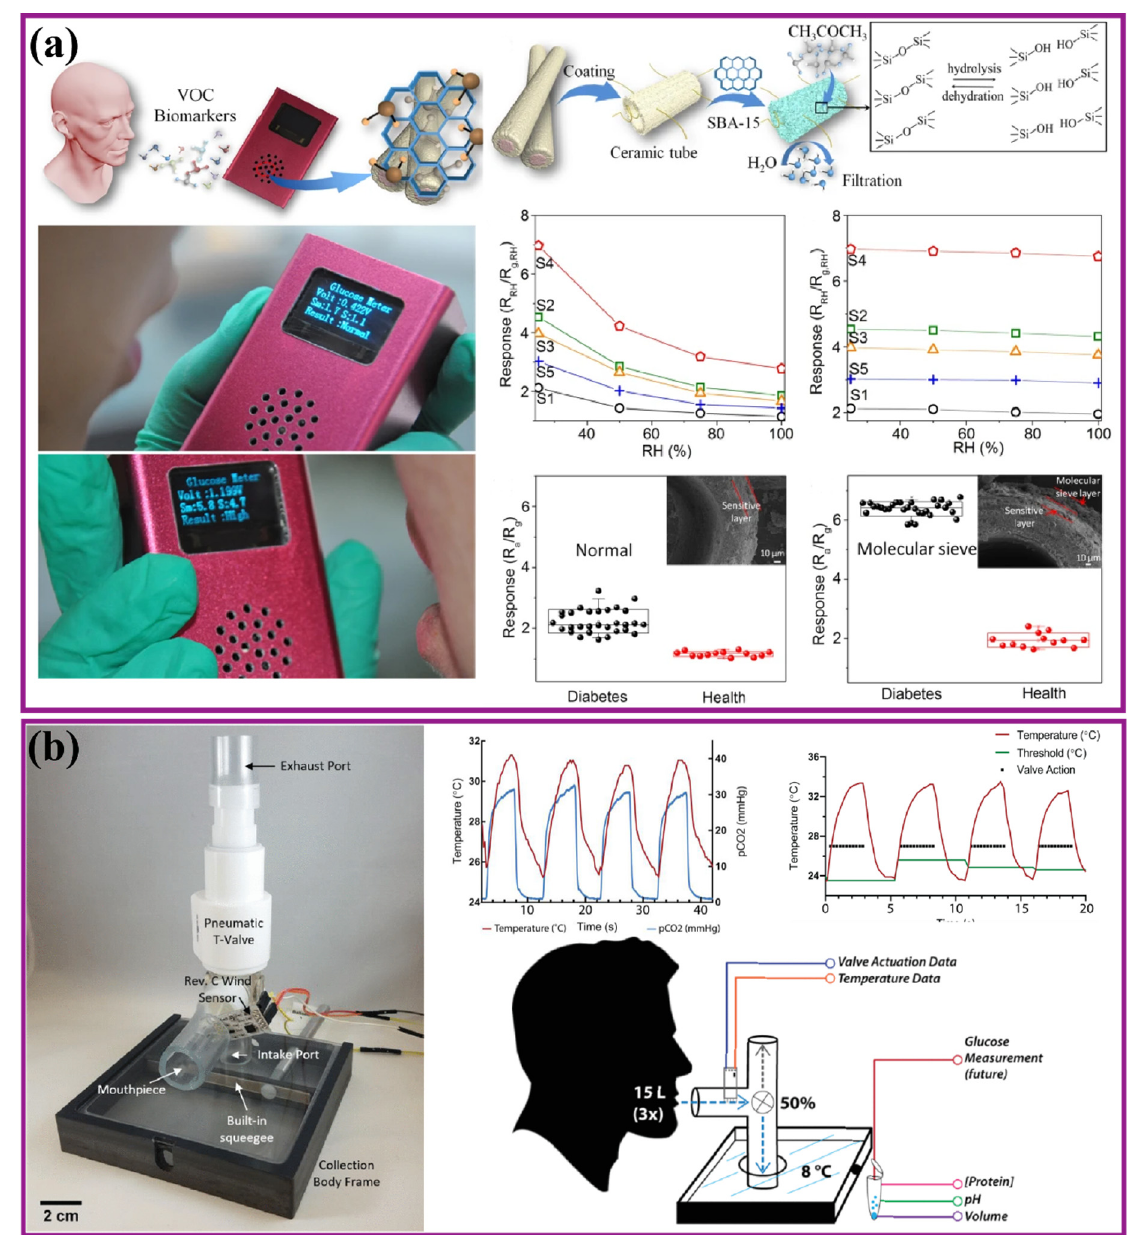
Figure 8. ( a ) Working principle of Pt@In2O3 core-shell NW portable sensing device along with the device response to exhaled breath from healthy as well as diabetic volunteers. (Reproduced with permission from Liu et al., NPG Asia Mater., vol. 10, no. 4, Apr. 2018 [138]. Copyright 2018, au-